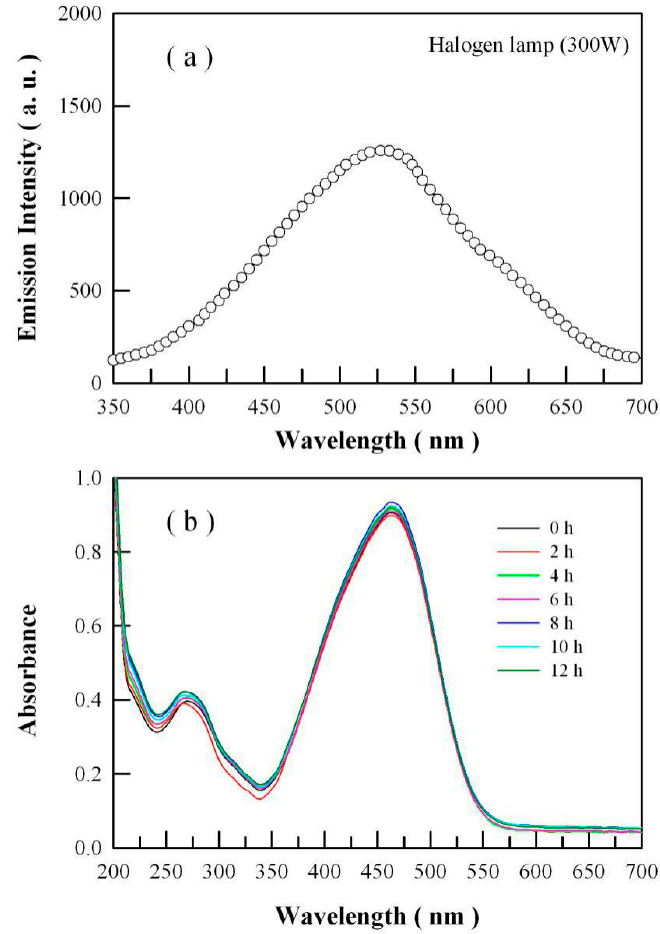
Figure 4. ( a ) Photoluminescence (PL) spectrum of a 300 W halogen lamp; ( b ) UV-Vis absorption spectra of methyl orange solution as a function of visible-light irradiation time in the absence of ZnO nanocrystals.